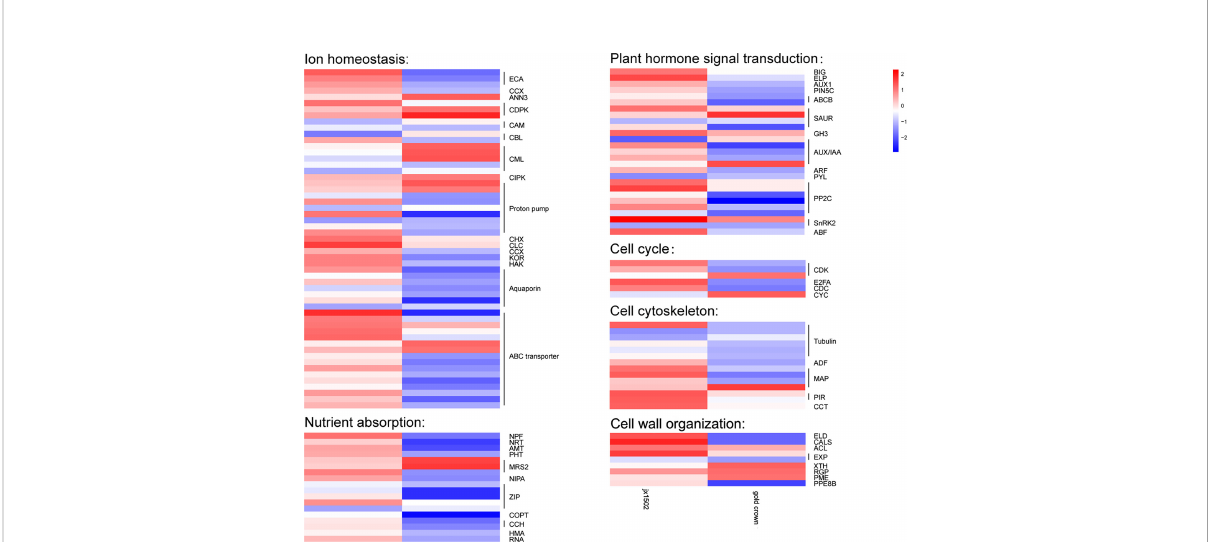
FIGURE 2 Heatmap of the expression patterns of the differentially expressed genes related to ion homeostasis, nutrient absorption, plant hormone signal transduction, the cell cycle, the cell cytoskeleton, and cell wall organization in ‘ jx1502 ’ (left) and ‘ gold crown ’ (right) under salt stress. The color scale represents the log2 value of the fold